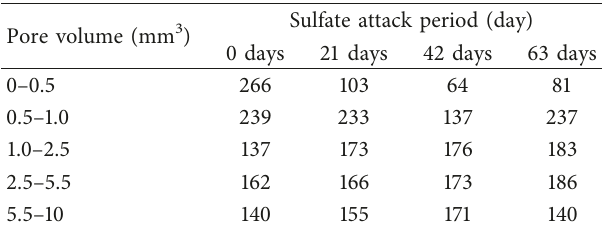
Table 5: Pore distribution of DW-2 exposed to drying-wetting cycles with sulfate attack.